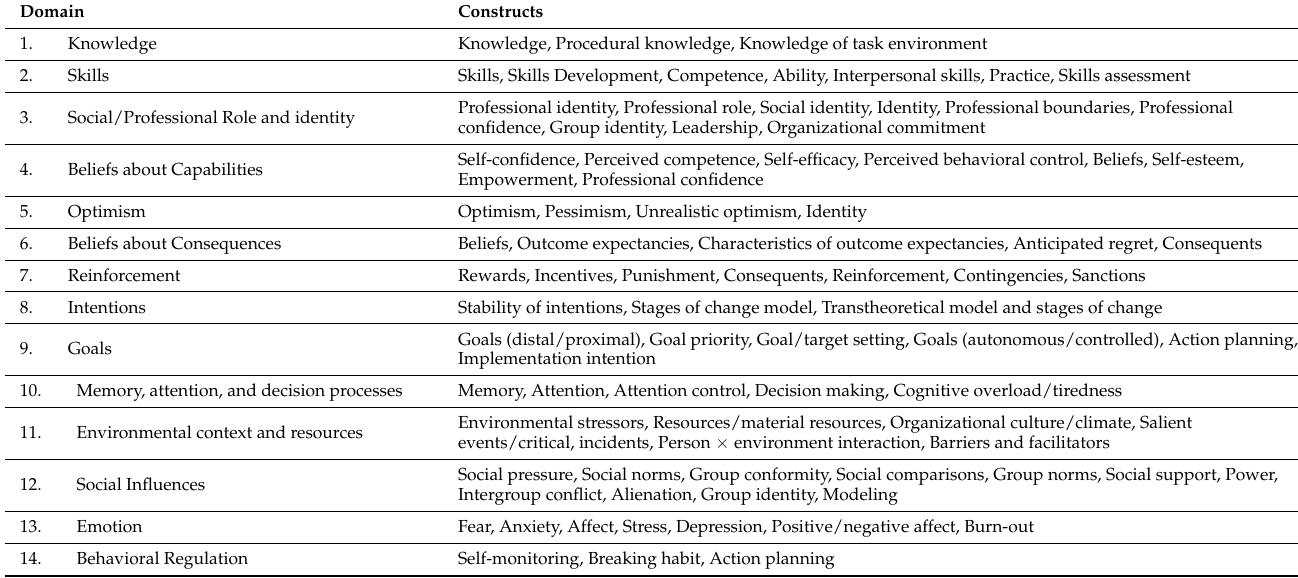
Table A1. The Theoretical Domains Framework domains and constructs